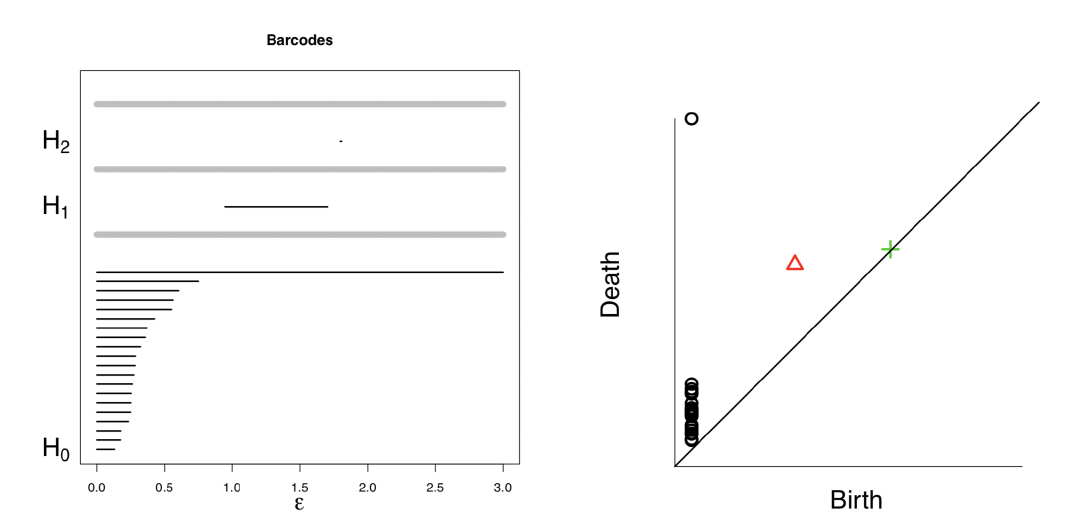
Figure 4. A barcode plot and the corresponding persistent diagram with H 0 , H 1 and H 2